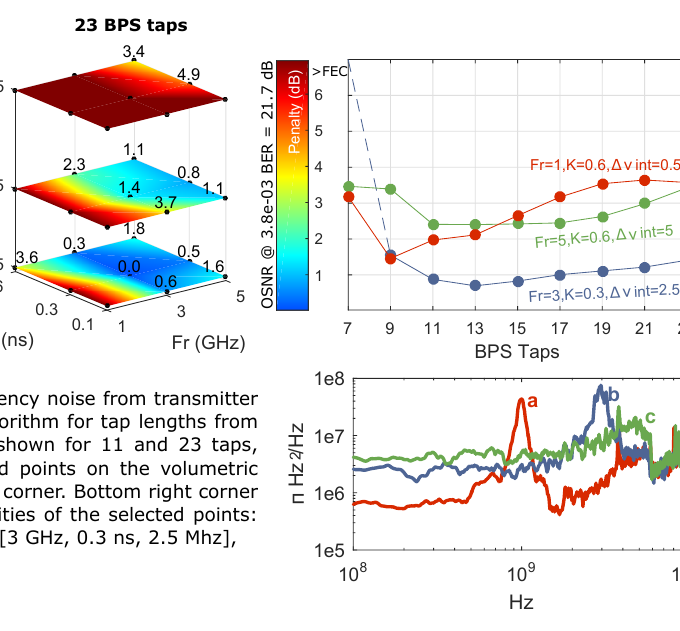
Figure 7. Experimental results for